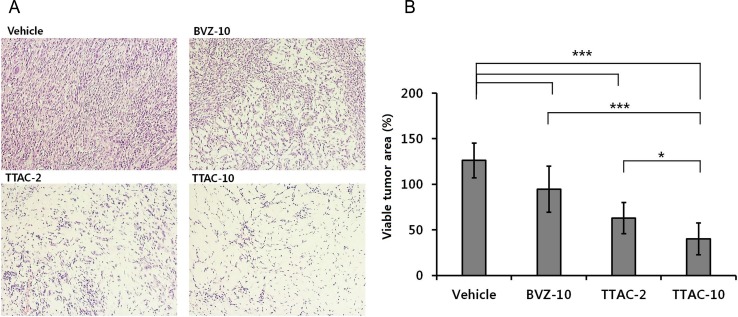
Histopathologic specimens with hematoxylin and eosin staining.(A) Microscope images (magnification × 200) of the four groups (control, BVZ-10, TTAC-2, TTAC-10). (B) The viable areas in tumors are shown for each group. Data are presented as mean ± sd in the graphs. ***, P < 0.001; **, P < 0.01; *, P < 0.05. BVZ-10, bevacizumab 10 mg/kg; TTAC-2, TTAC-0001 2 mg/kg; TTAC-10, TTAC-0001 10 mg/kg.